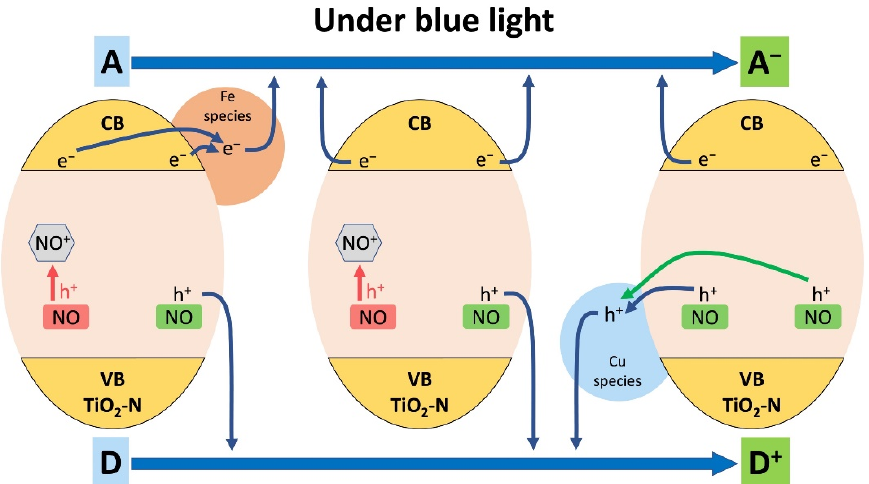
Figure 11. Energy diagram for Fe/TiO 2 -N ( left ), TiO 2 -N ( center ), and Cu/TiO 2 -N ( right ). Highly active N-doped TiO 2 photocatalysts with a visible-light response have